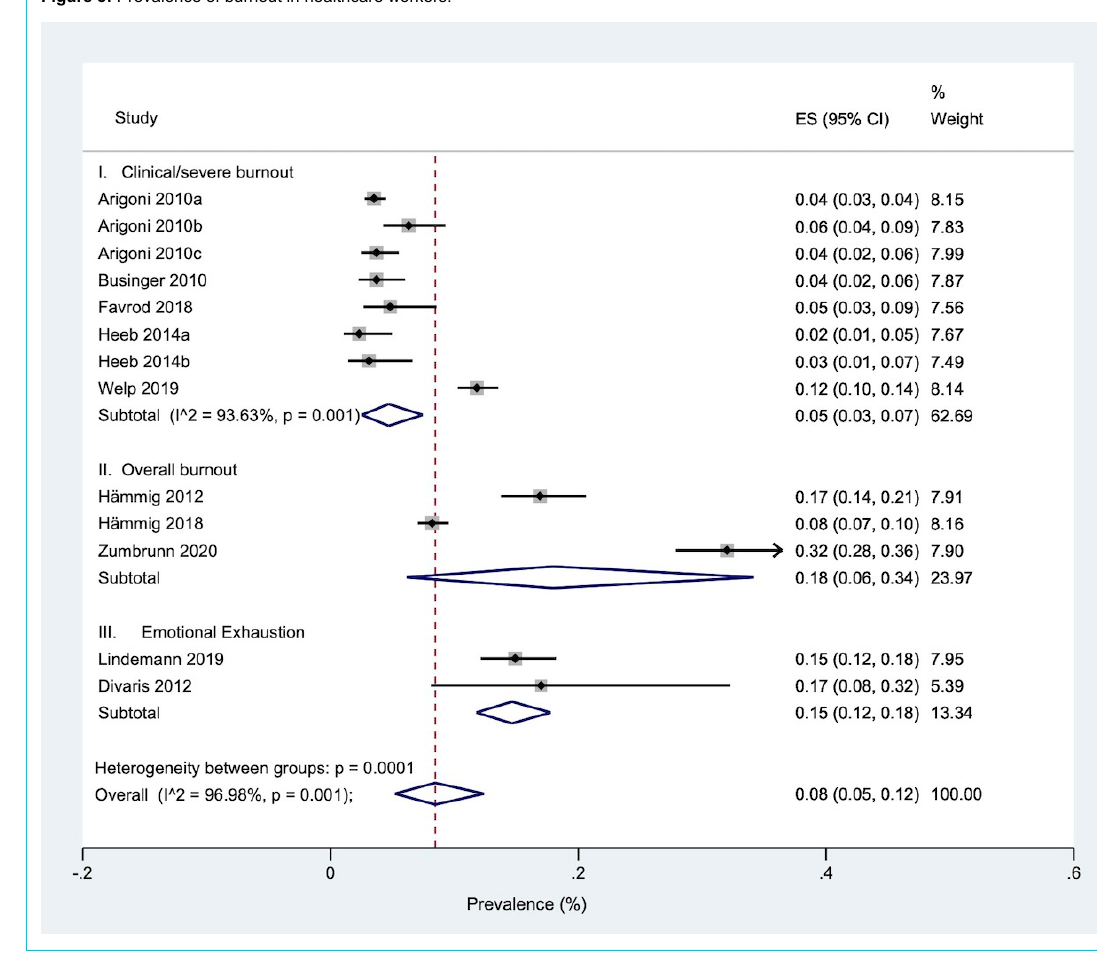
Figure 3: Prevalence of burnout in healthcare